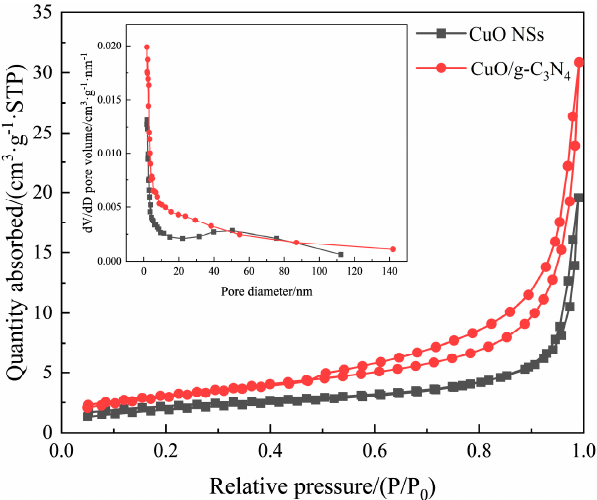
Figure 3. N 2 adsorption–desorption isotherm and BJH pore size distribution plots (insets) of CuO NSs and CuO/g-C 3 N 4 .